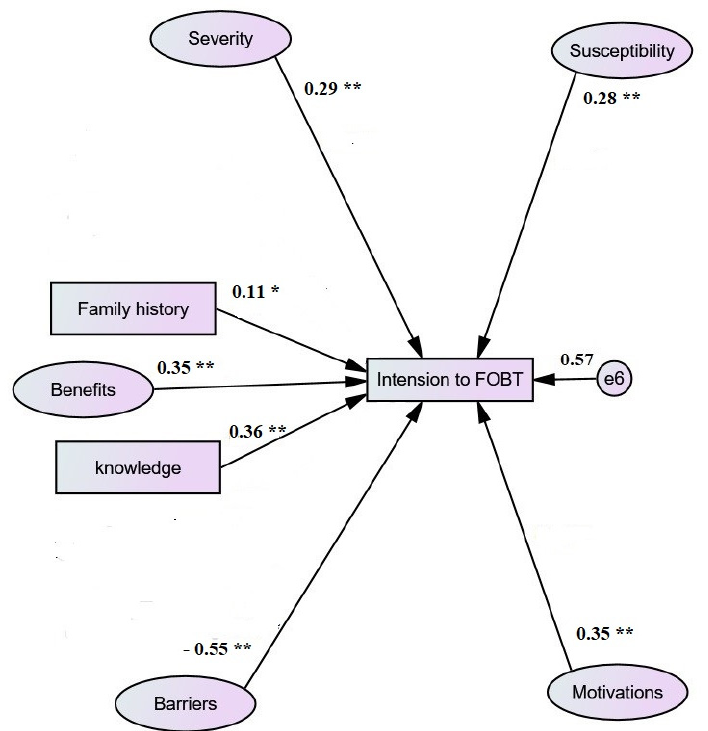
Figure 2. The modified stable model predicting screening practice intention. * p < 0.05, ** p < 0.001. All regression estimates are standardized β coefficients.